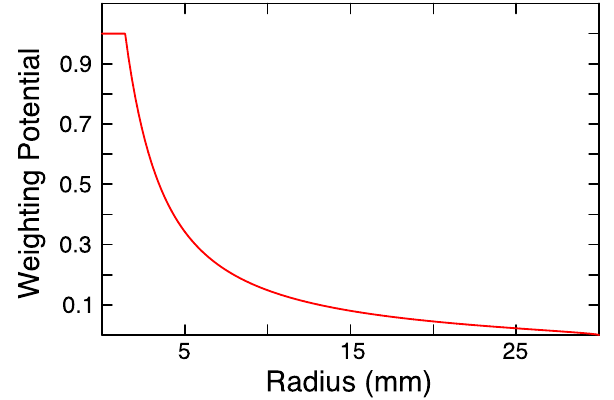
Fig. 12 The weighting potential at z = 0 (i.e. events originating at the passivated surface) for the PONaMa-1 detector, calculated using mjd_fieldgen . Note that the electron contribution to the signal is small over most of the surface, and rises dramatically at small